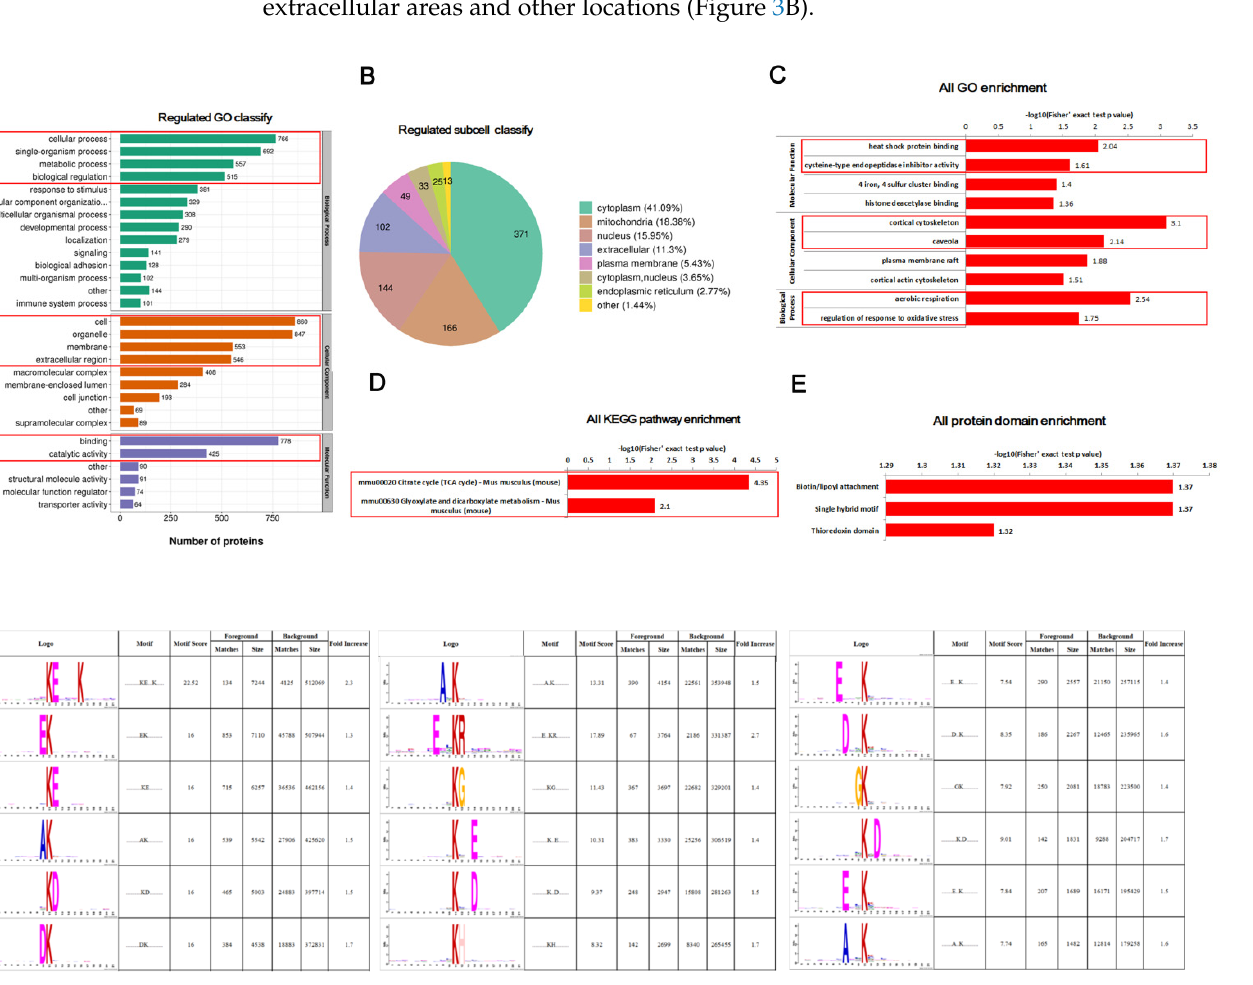
Figure 3. Non-histone crotonylation modification regulates white fat browning. Note: ( A ) GO secondary annotation of crotonylated proteins; ( B ) subcellular localization of crotonylated proteins; ( C – E ) enrichment analysis of crotonylated protein GO, KEGG and crotonylated modified domains; ( F ) crotonylation modification sequence motif of ±10 amino acids around the Kcr site.